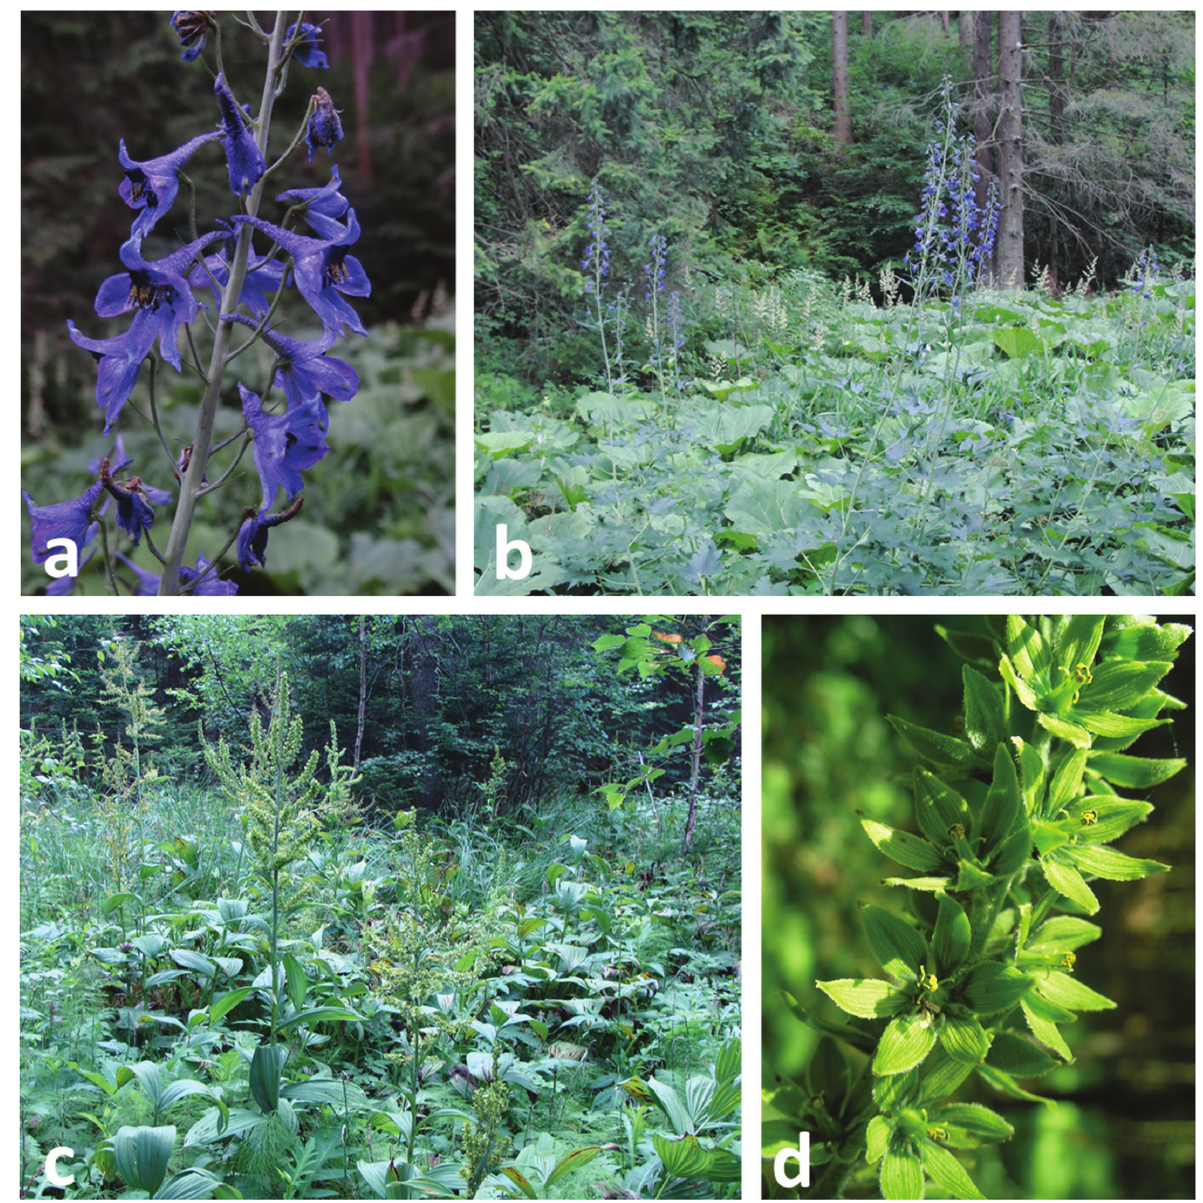
Figure 4. Tall-forb vegetation belonging to the Petasito-Chaerophylletalia . a–b. Delphinium elatum in the Kleśnica valley (Śnieżnik Massif, Eastern Sudetes) where it occurs in the plots of the Petasitetum hybridi and Chaerophyllo hirsuti-Petasitetum albi ; c‒d. Prenanthetum purpureae in the Stołowe Mts. (Eastern Sudetes) with the presence of Veratrum lobelianum . (Photographs a-d K.